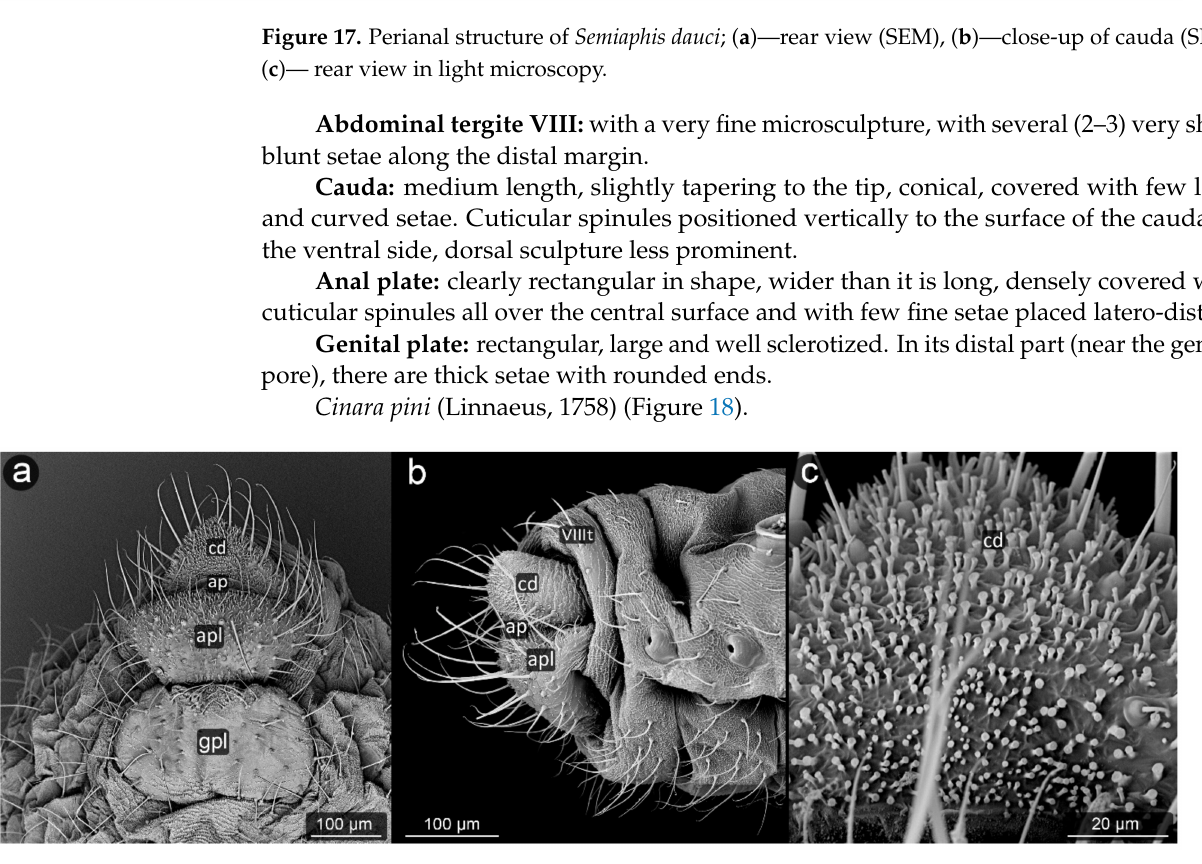
Figure 18. Perianal structure of Cinara pini in SEM; ( a )—rear view, ( b )—lateral view, ( c )—close-up on the surface of cauda-protruding